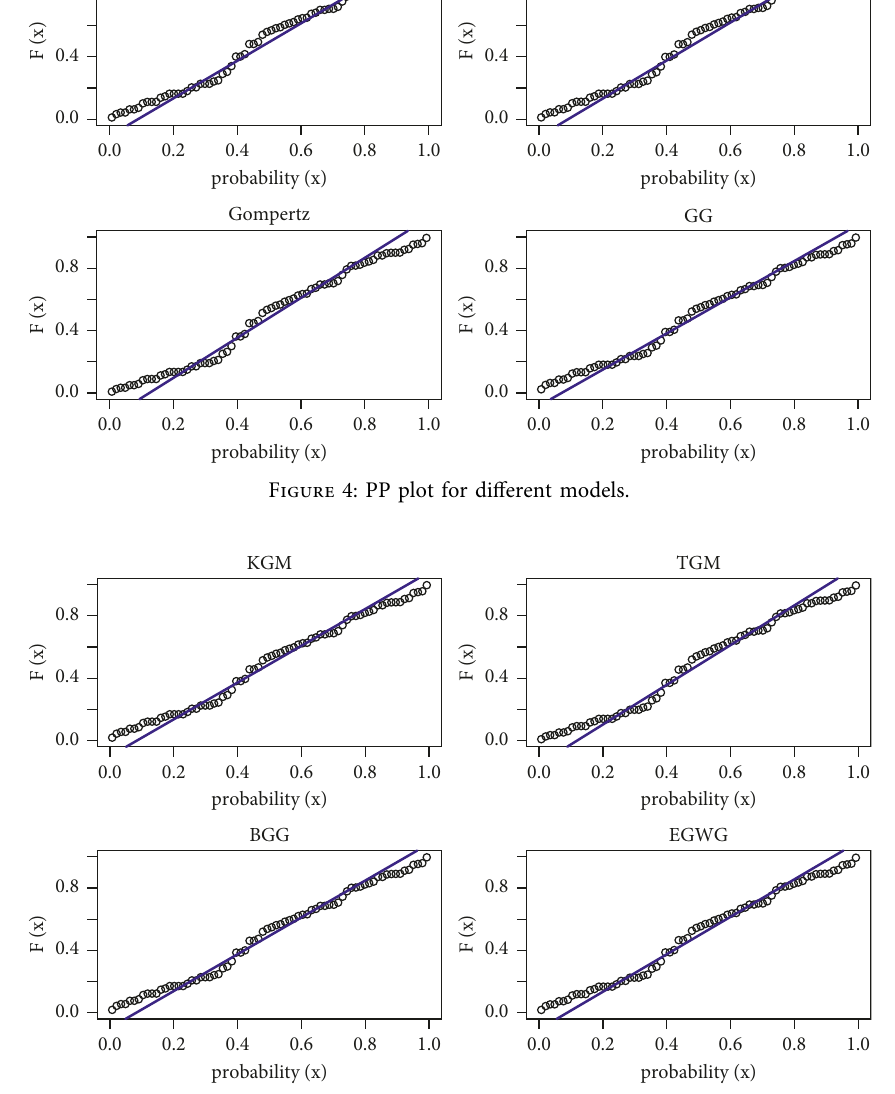
Figure 5: PP plot for different models. Table 5: MLE and Bayesian estimation methods comparing by SE: flood peaks